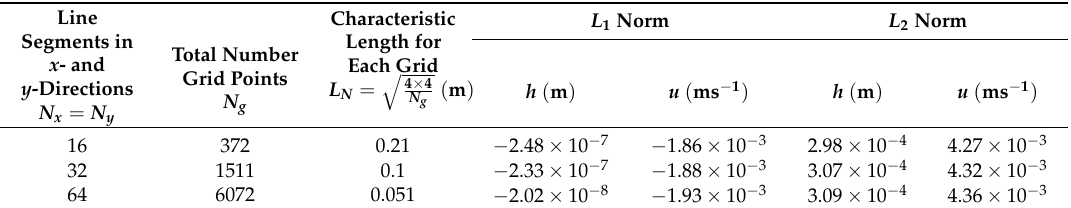
Table 2. Grid properties and error-norm for Thacker’s planar solution.